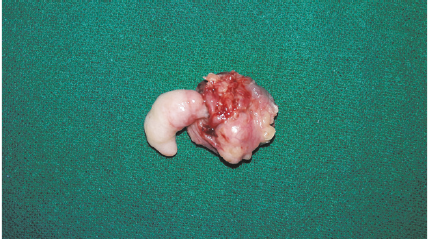
Figure 1: Gross photograph of left tonsillectomy specimen showing a polypoidal mass arising from upper pole.